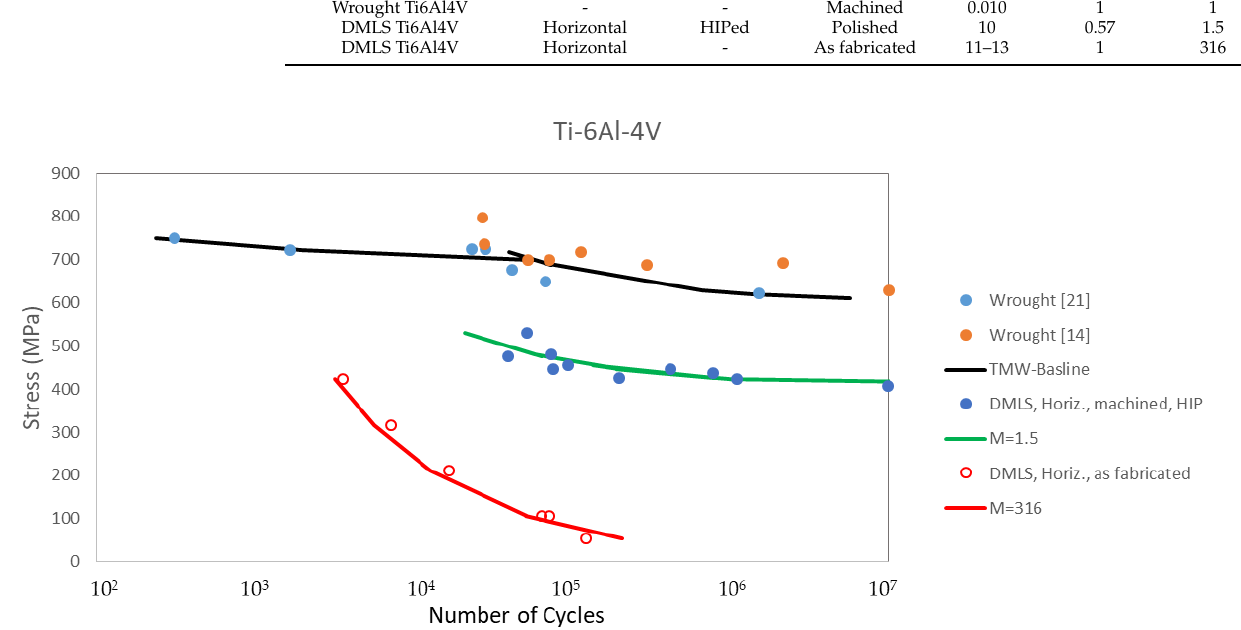
Figure 5. Fatigue behaviours of wrought and AM Ti6Al4V.